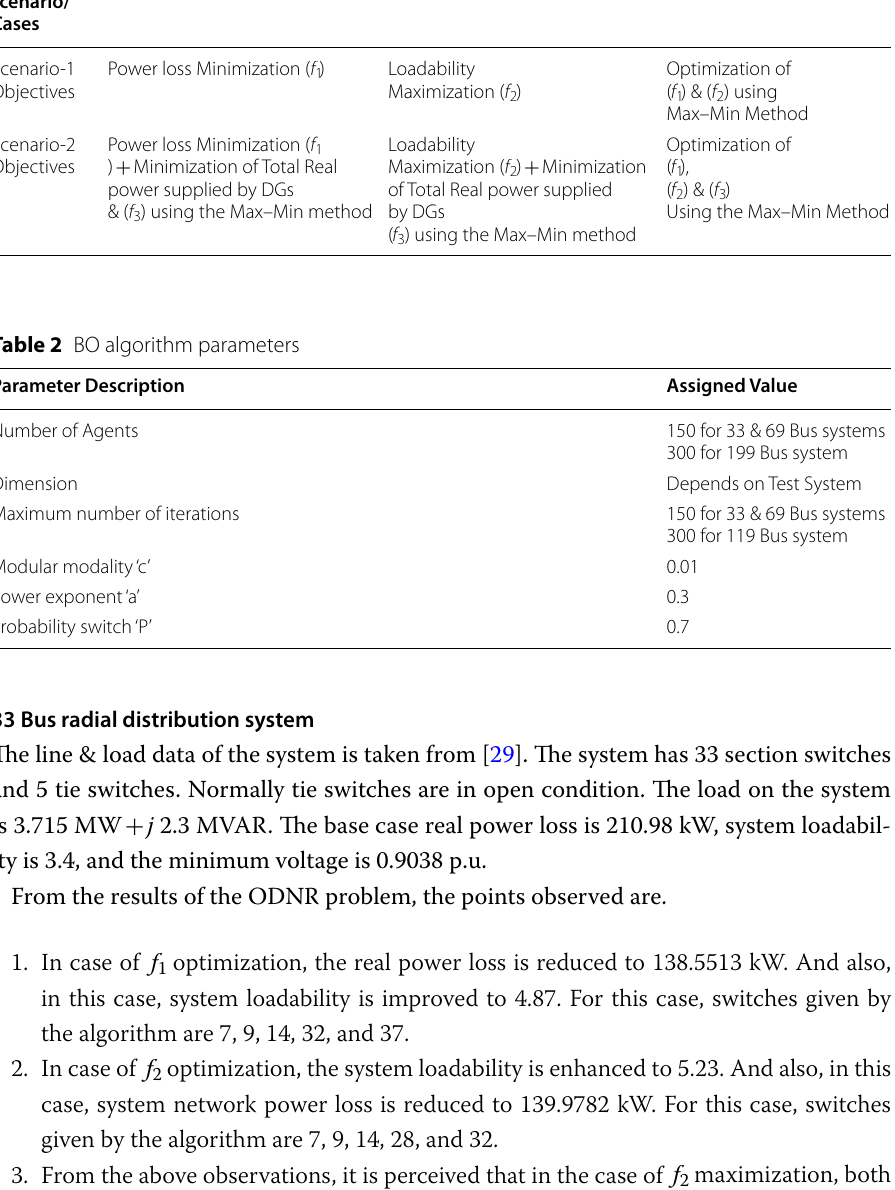
Table 1 Scenarios and cases considered in this paper Type of scenario/ Cases